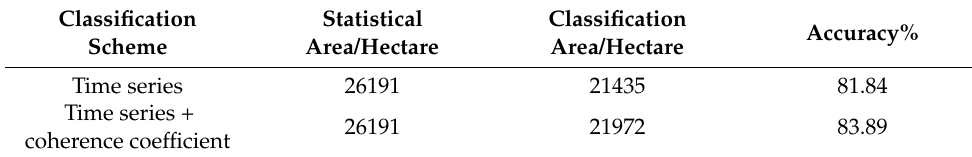
Table 10. Statistical accuracy of rice